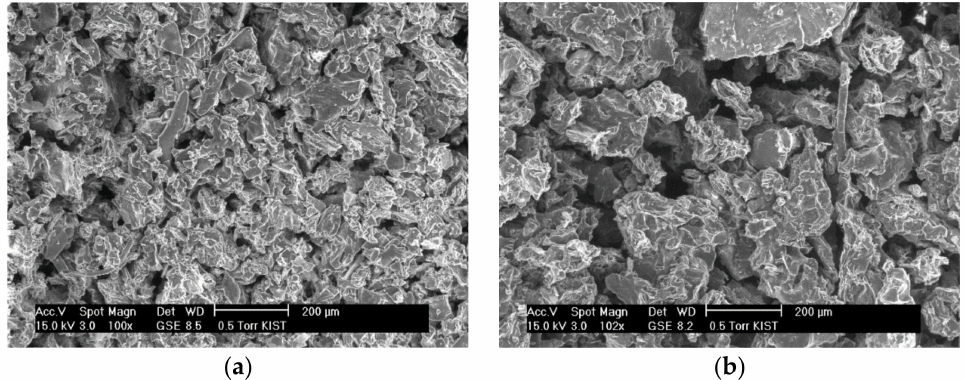
Figure 3. Scanning electron microscopy (SEM) images of blueberry ( a ), and chokeberry ( b )